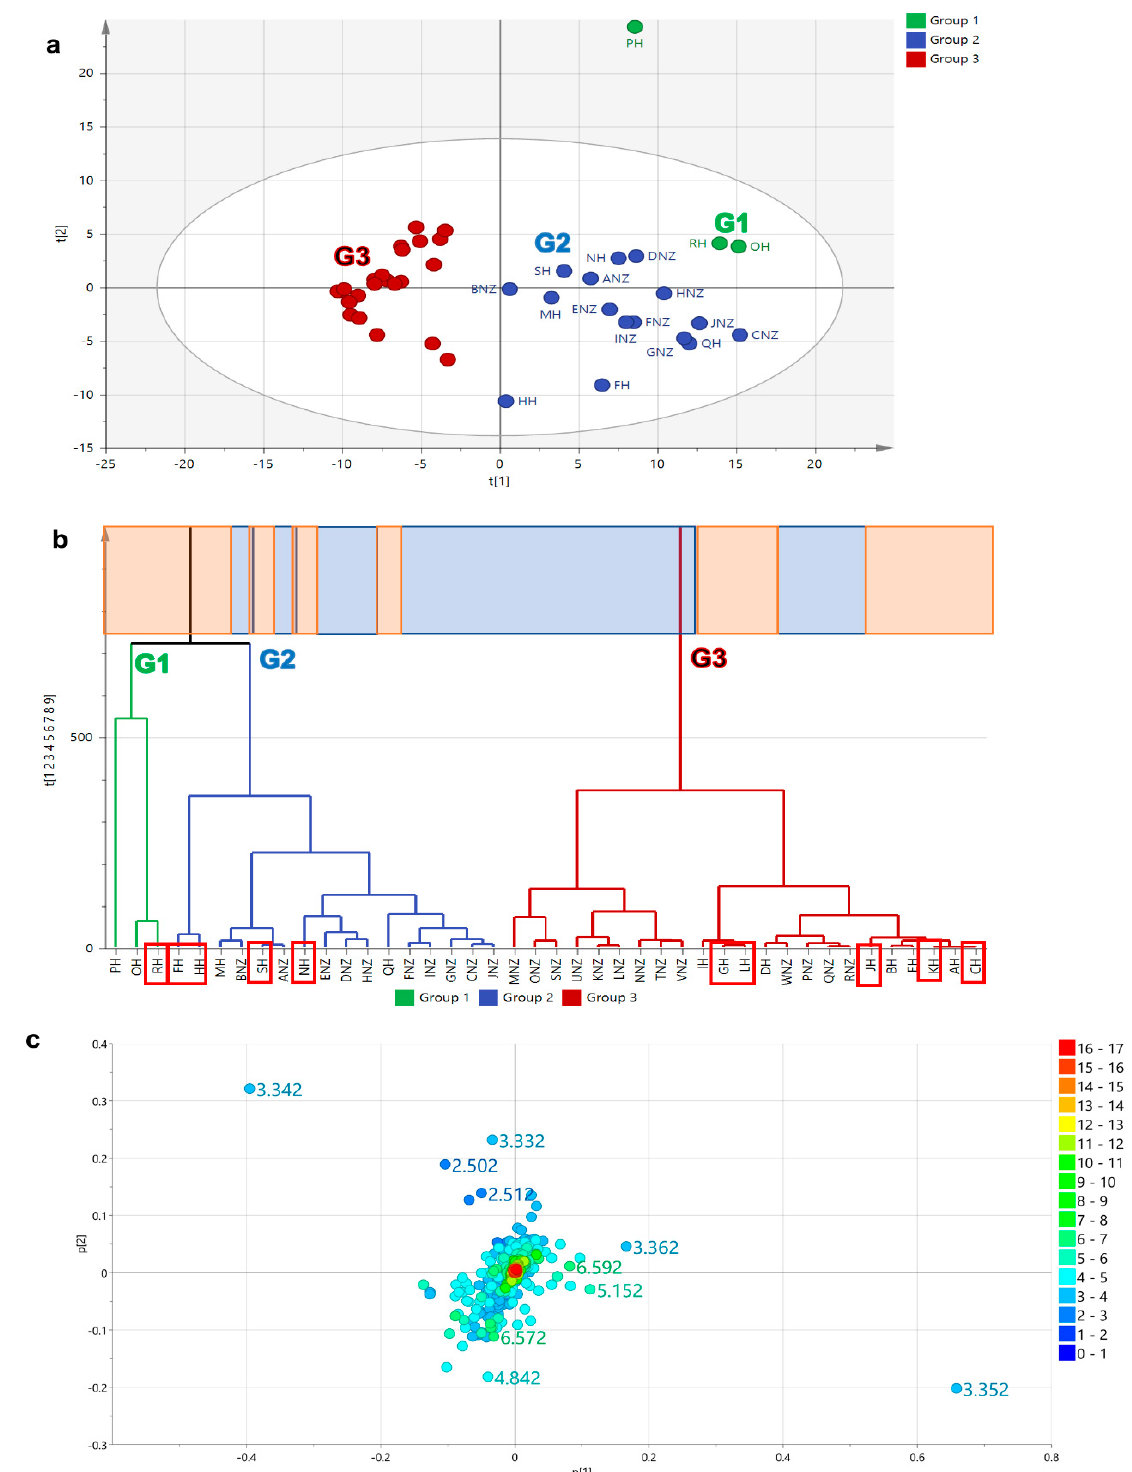
Figure 2. PCA model employing the NMR spectral dataset: ( a ) Scores, ( b ) HCA, and ( c ) loadings plots on honey extracts based on 1 H NMR spectral dataset, which gave a relatively good model and prediction (R 2 = 0.92 and Q 2 = 0.68). Bioactive samples were boxed in red. Highlighted upper boxes on the HCA dendrogram ( b ) represents origin of honey samples where blue represents the New Zealand (NZ) samples while the Malaysian samples were highlighted in orange.